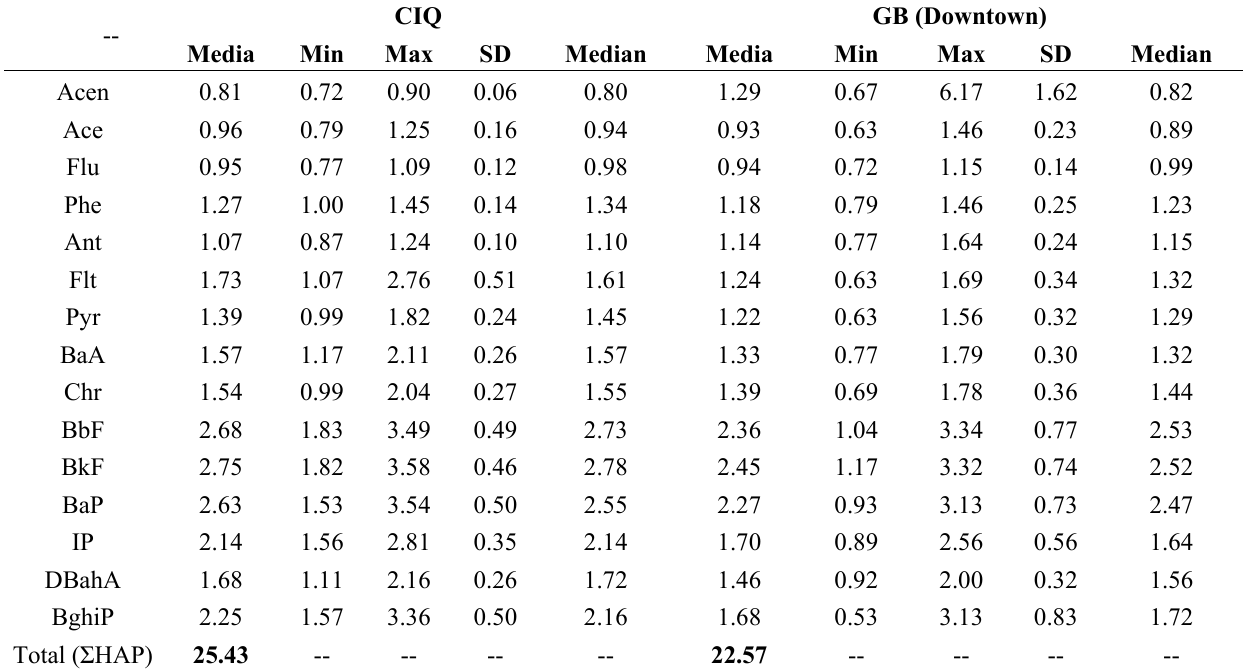
Table 1. Average concentration of PAHs associated with particulate matter PM 2.5 in two places of the city of Cuernavaca, Morelos during the winter season of 2013 (ng·m − 3 ). --